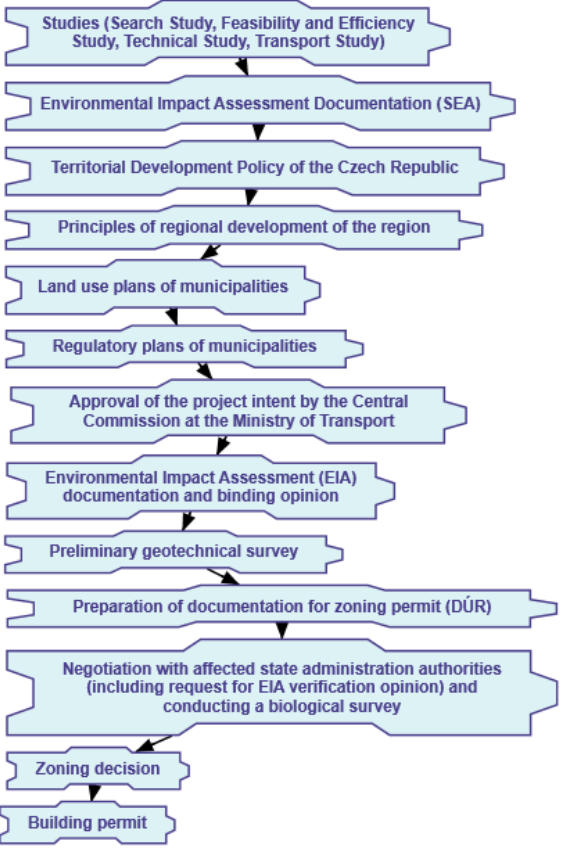
Figure 2. Predictive live cycle, source: custom.